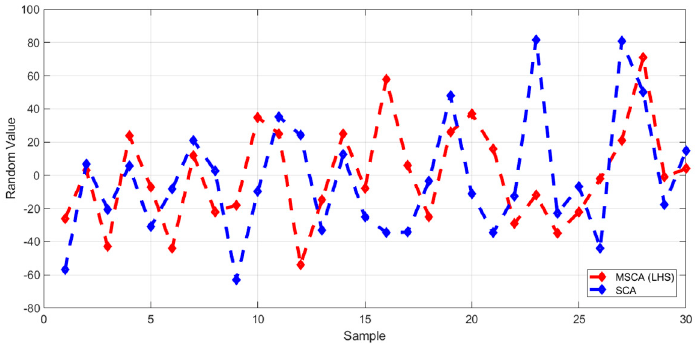
Figure 2. The random sample value of the Sine Cosine Algorithm (SCA) with and without Latin Hypercube Sampling (LHS).